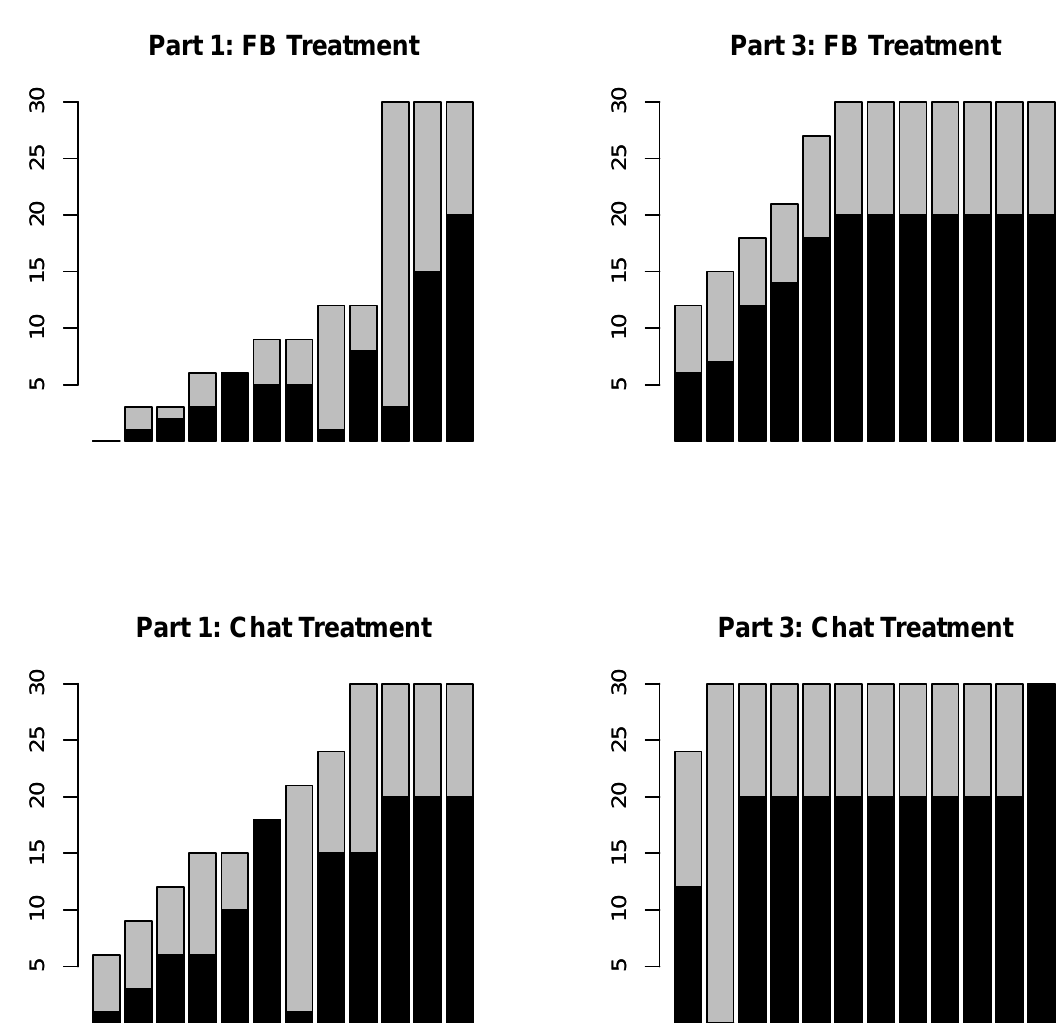
Figure 2. Facebook-to-Facebook (FB) and Chat communication: amount sent tripled (grey) and amount returned (black), by